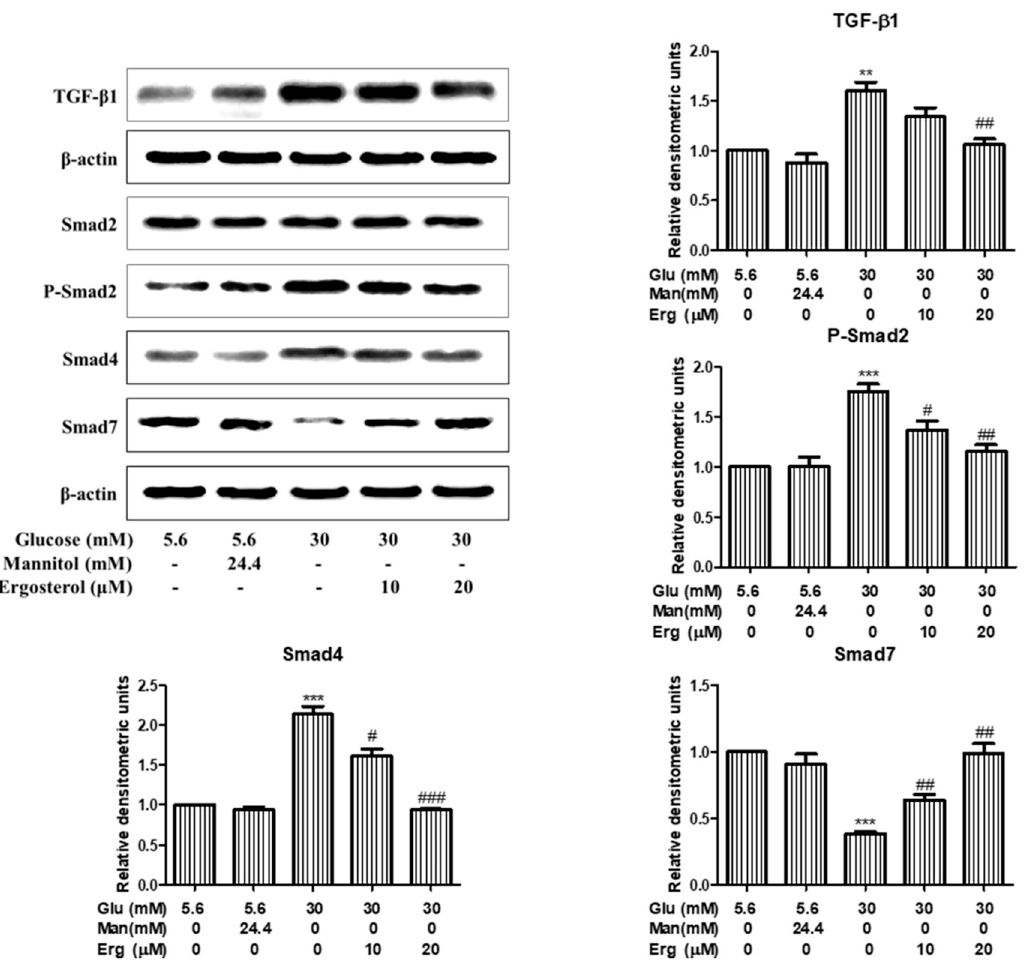
Figure 7. Ergosterol inhibited the TGF- β 1/Smad2 signaling pathway in RMCs exposed to high glucose. This figure shows the expression levels of TGF- β 1, Smad2, phosphorated-Smad2, Smad4, and Smad7 in RMCs cultured under different conditions through Western blotting. Glu: glucose; Man: mannitol; Erg: ergosterol. Data are presented as the means ± SD, performed in triplicate. ** p <0.01, *** p <0.001 compared with normal glucose; # p <0.05, ## p <0.01, ### p <0.001 compared with high glucose.